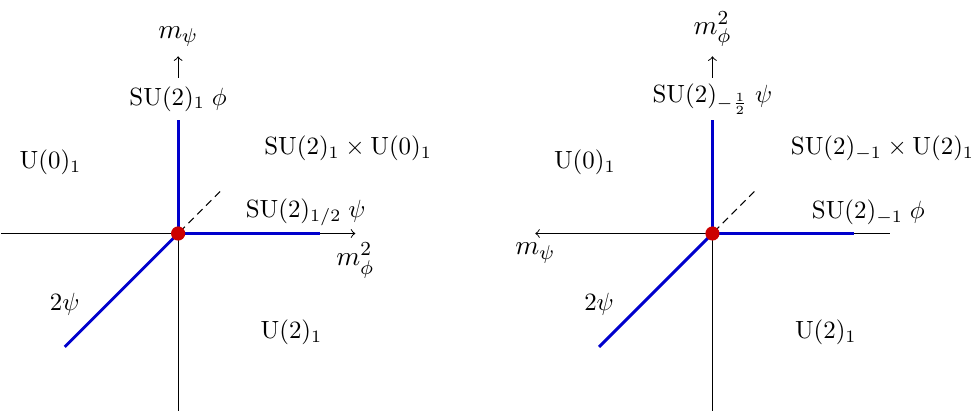
Figure 7 . USp(2) 1 with φ, ψ USp(2) − 1 with φ, ψ . Phase diagram. We have not indicated ←→ 2 2 the gravitational couplings along gapless lines, for simplicity. The duality predicts emergent IR time-reversal invariance at the origin and along the dashed